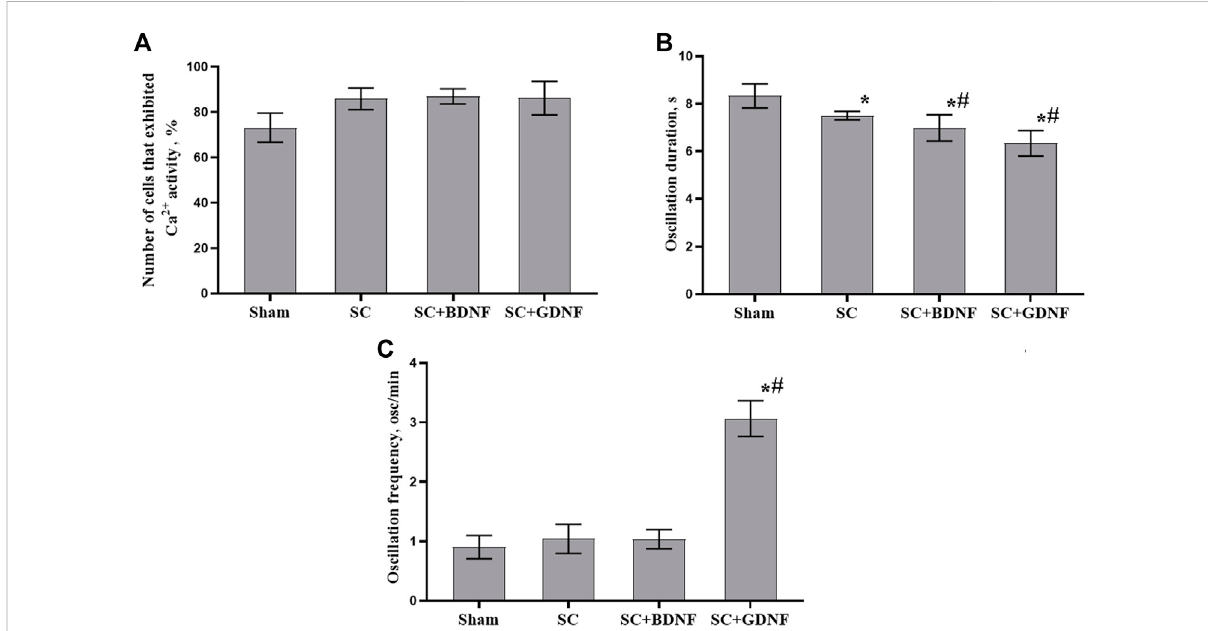
FIGURE 4 Main parameters of spontaneous calcium activity in primary hippocampal cultures on day 14 of development in vitro . (A) Proportion of cells exhibitingCa 2+ activity, (B) DurationofCa 2+ oscillationsinseconds, (C) NumberofCa 2+ oscillationspermin.Thevaluesarethemean±standarderror ofthemeanandrepresentthreeindependentexperimentswith fi vereplicatesineach.Statisticalsigni fi cancewascalculatedbyone-wayANOVAand Tukey post hoc test. * - versus Sham, # - versus SC, p <